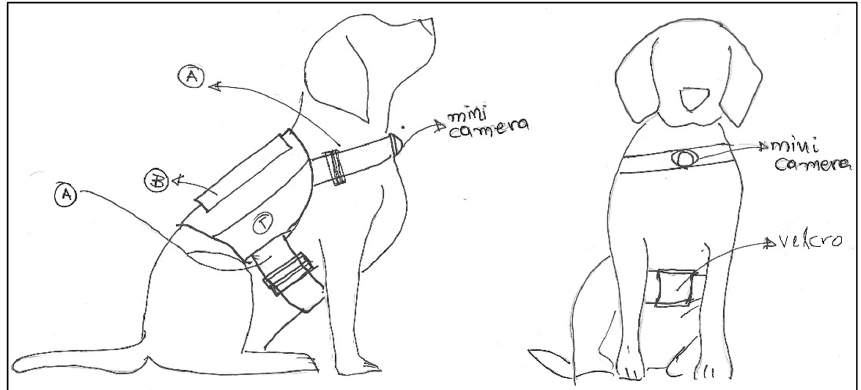
Figure 2. Drawing displaying placement of animal wearable.